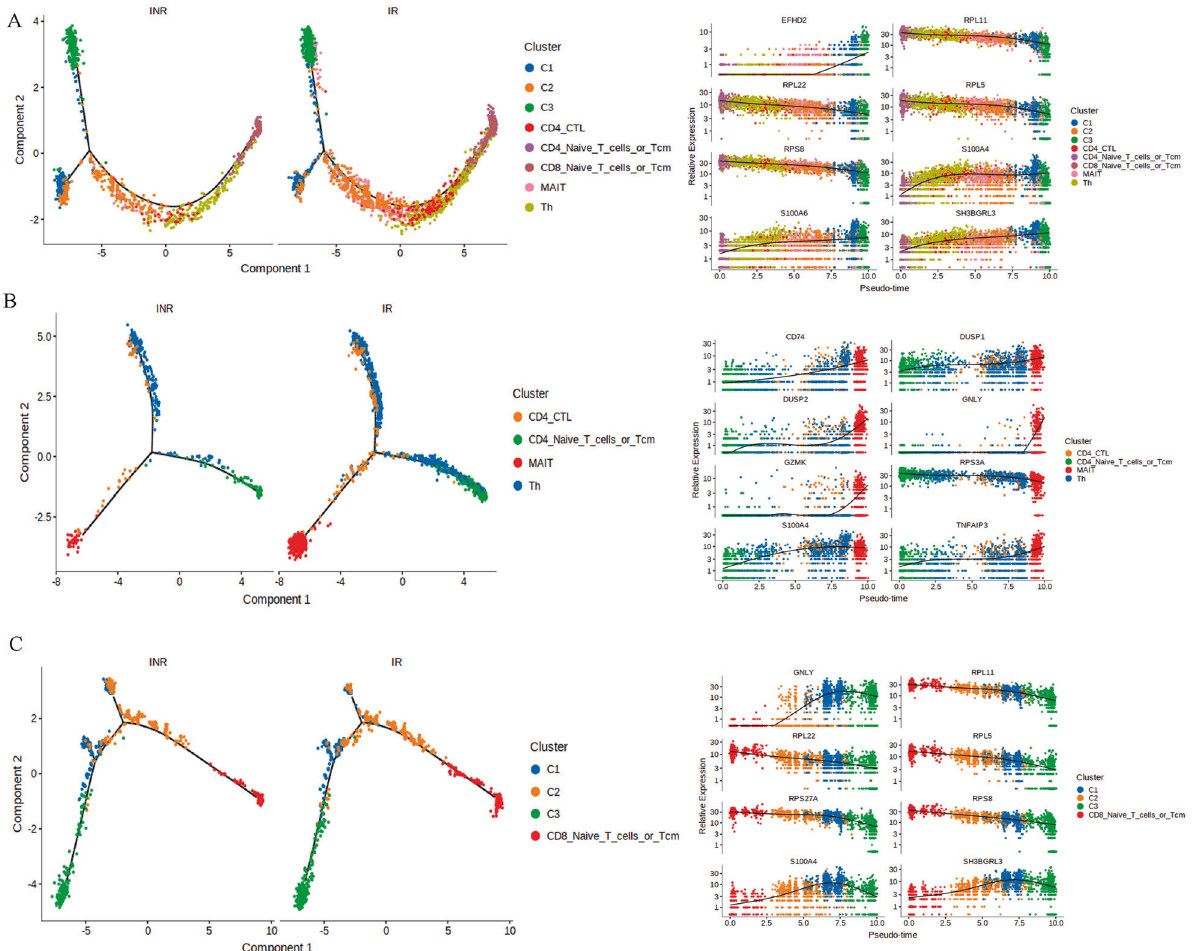
Fig. 7 The differentiation state of T cells in INRs and IRs. A Pseudotime trajectory of T cells estimated using Monocle 2. A continuous value from 0 to 12 was assigned to each cell as a pseudotime. (Right) Expression transition of differentiation-associated genes along the pseudotime. B Pseudotime trajectory of CD4 CTL, MAIT, and Th cells estimated using Monocle 2. (Right) Expression transition of differentiation-associated genes along the pseudotime. C Pseudotime trajectory of CD8 effector T cells estimated using Monocle